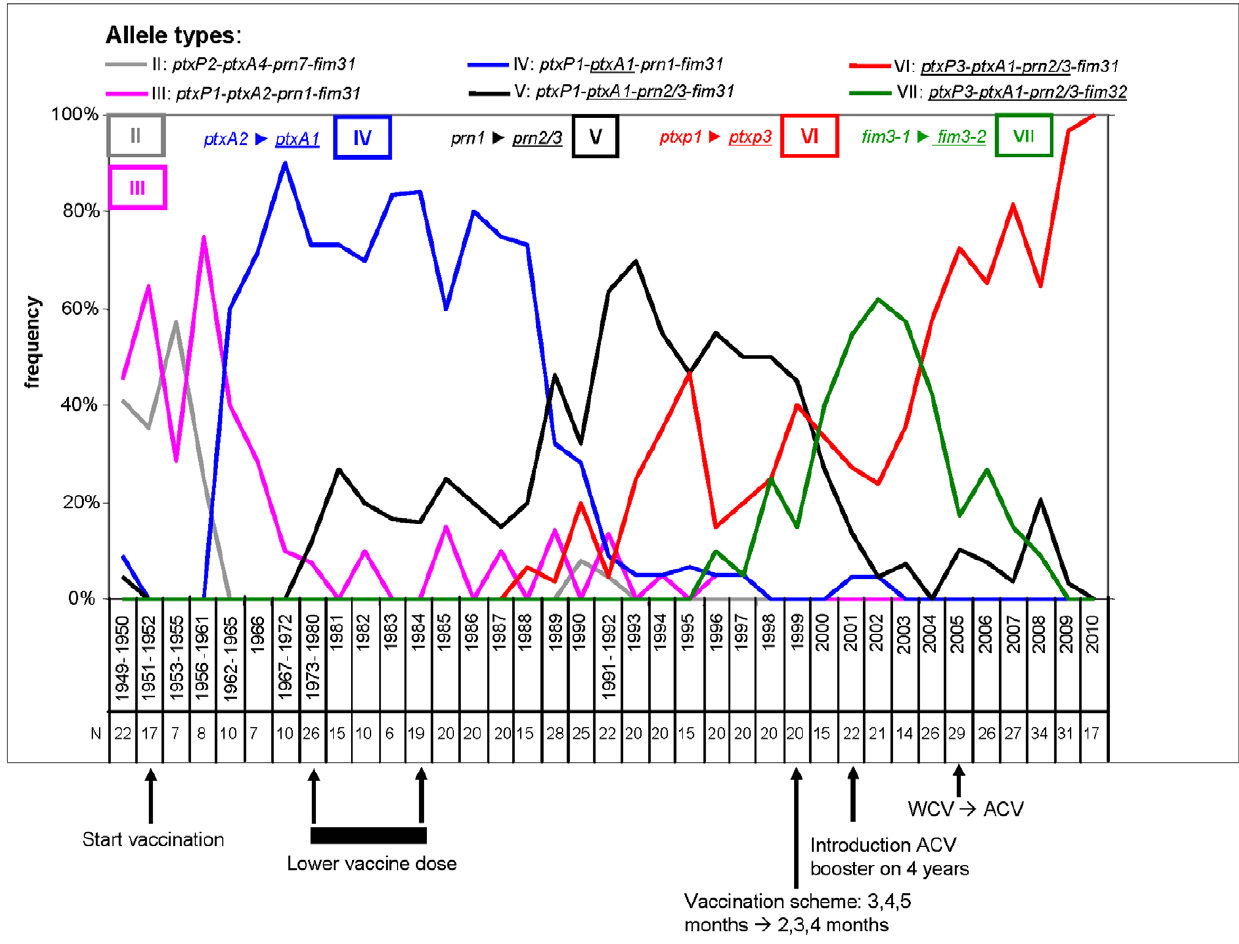
Figure 2. Temporal trends in strain frequencies and notifications in The Netherlands in the period 1949–2010. Strain frequencies are indicated by coloured lines. Strains were aggregated into allele types (ATs) defined by the combination of alleles for ptxP , ptxA , prn and fim3 as shown in the top of the graph. No distinction was made between strains with the prn2 and prn3 alleles. ATs are indicated by blocked Roman numbers and allele changes resulting in differences between ATs are indicated. Non-vaccine type alleles are underlined. ATs found in one or two periods only, with a frequency lower than 15%, are not shown. If necessary, years were combined to increase the number of analyzed strains to at least 6. Note that due to this, the X-axis is not proportional. Changes in the vaccination program are indicated below the X-axis. From 1962 to 1999, four doses of WCV were given at the ages 3, 4, 5 and 11 months. In 1999, the schedule was changed to 2, 3, 4 and 11 months. In 2001, a booster with an ACV was introduced for 4 year olds and in 2005 the WCV was replaced by an ACV for all age categories. Between 1975 and 1984, the WCV dose was temporarily reduced. Abbreviations: N, number of strains analysed; WCV, whole cell vaccine; ACV, acellular vaccine.